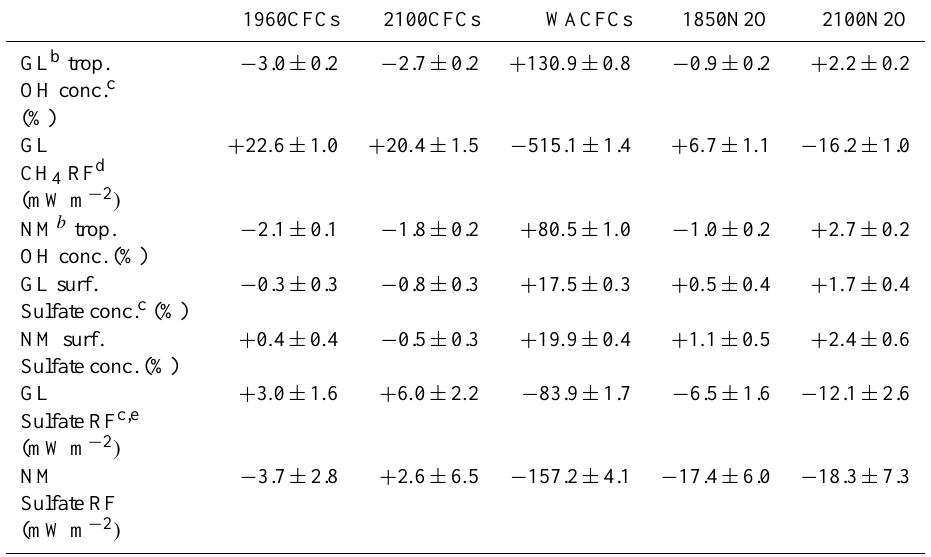
Table 2. Differences in annual mean tropospheric OH concentration, surface sulfate aerosol concentration, methane and sulfate aerosol instantaneous top-of-the-atmosphere (TOA) radiative forcing (RF), between the sensitivity experiments and the BASE run a .